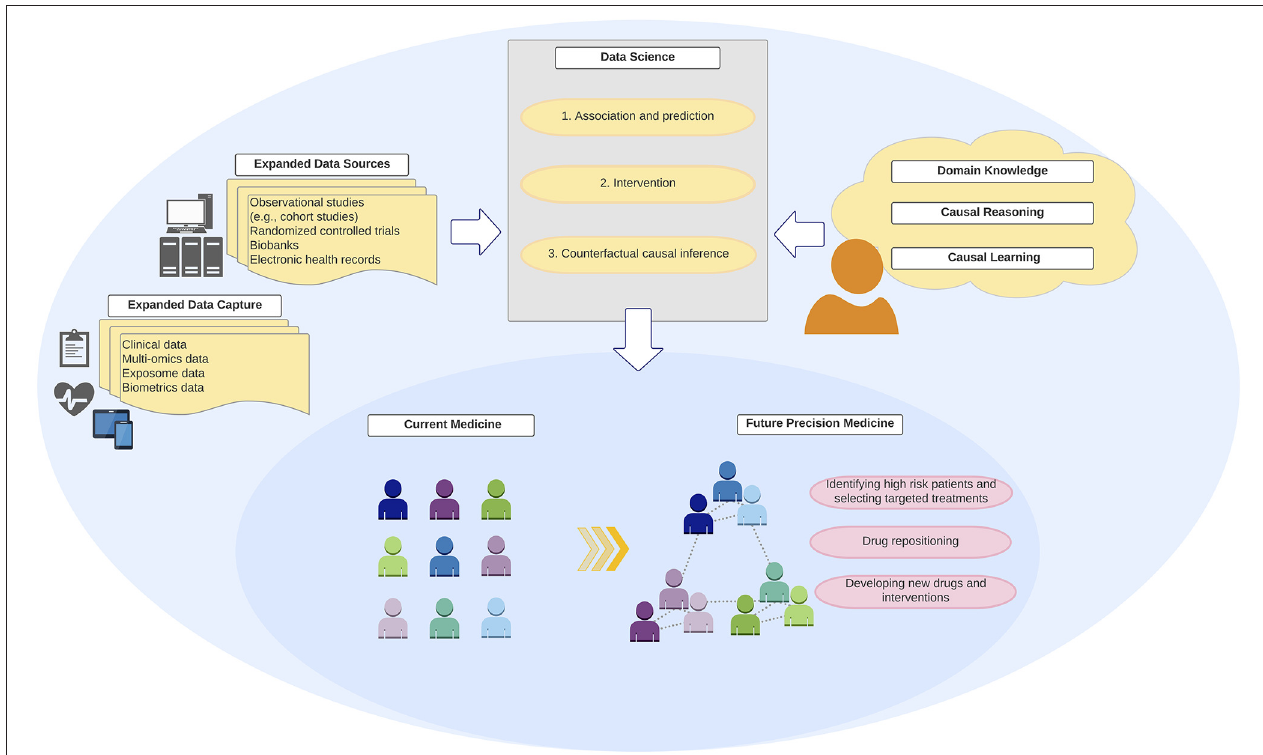
FIGURE 3 | Integration of “big data,” data science, and domain knowledge toward precision medicine. Development of precision medicine requires an integration of “big data” from expanded data sources and capture with robust data science methodologies and analytics that encode domain causal knowledge and counterfactual causal